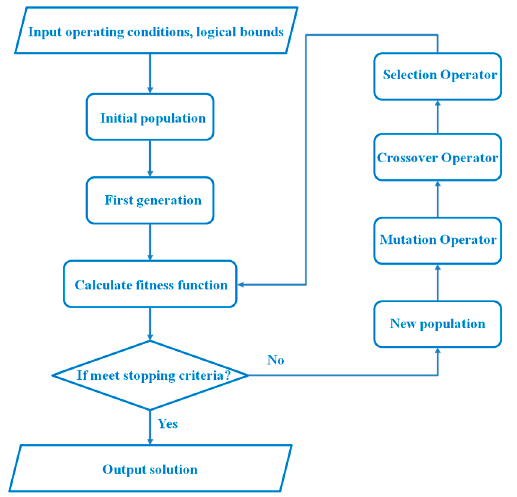
Figure 4. Flowchart of the genetic algorithm.